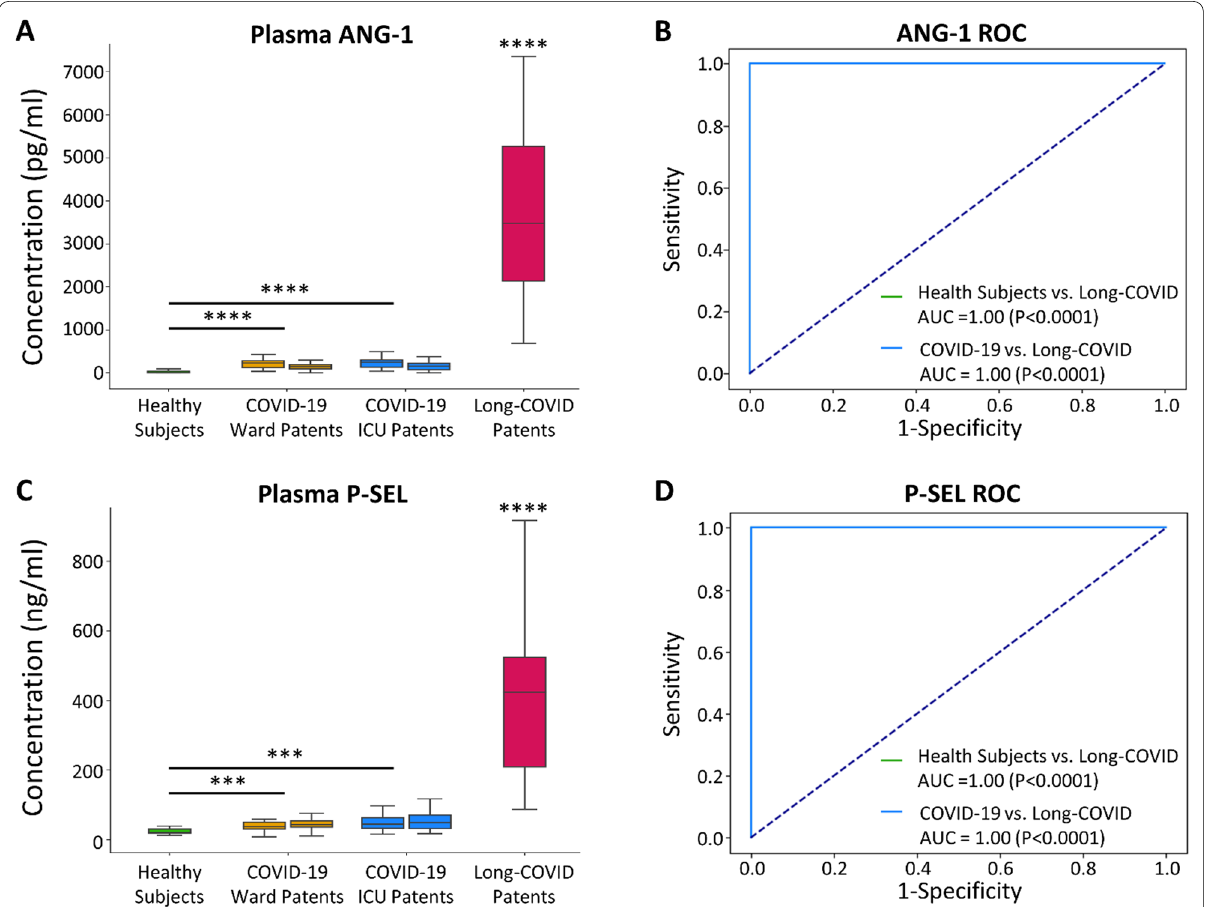
Fig. 3 Box plots and receiver operating characteristic (ROC) curves for leading biomarkers, ANG-1 and P-SEL. A A boxplot demonstrating significantly elevated blood ANG-1 concentrations in Long-COVID outpatients (****P < 0.0001). B ROC curves demonstrating the excellent Long-COVID classification potential of blood ANG-1 versus healthy control subjects (AUC 1.00, P < 0.0001) and acutely ill COVID-19 inpatients = (AUC 1.00, P < 0.0001). ROC curve for Long-COVID versus healthy control (green) hidden by ROC curve for Long-COVID versus acutely ill COVID-19 = patients. C A boxplot demonstrating significantly elevated blood P-SEL concentrations in Long-COVID outpatients (****P < 0.0001; ***P < 0.001). D ROC curves demonstrating the excellent Long-COVID classification potential of blood P-SEL versus healthy control subjects (AUC 1.00, P < 0.0001) = and acutely ill COVID-19 inpatients (AUC 1.00, P < 0.0001). ROC curve for Long-COVID versus healthy control (green) hidden by ROC curve for = Long-COVID versus acutely ill COVID-19